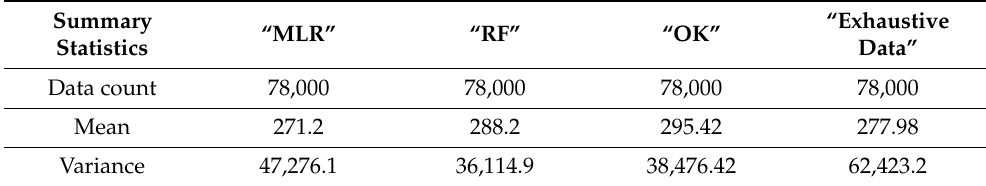
Table 7. Summary Statistics for Actual Exhaustive data vs. Models prediction.